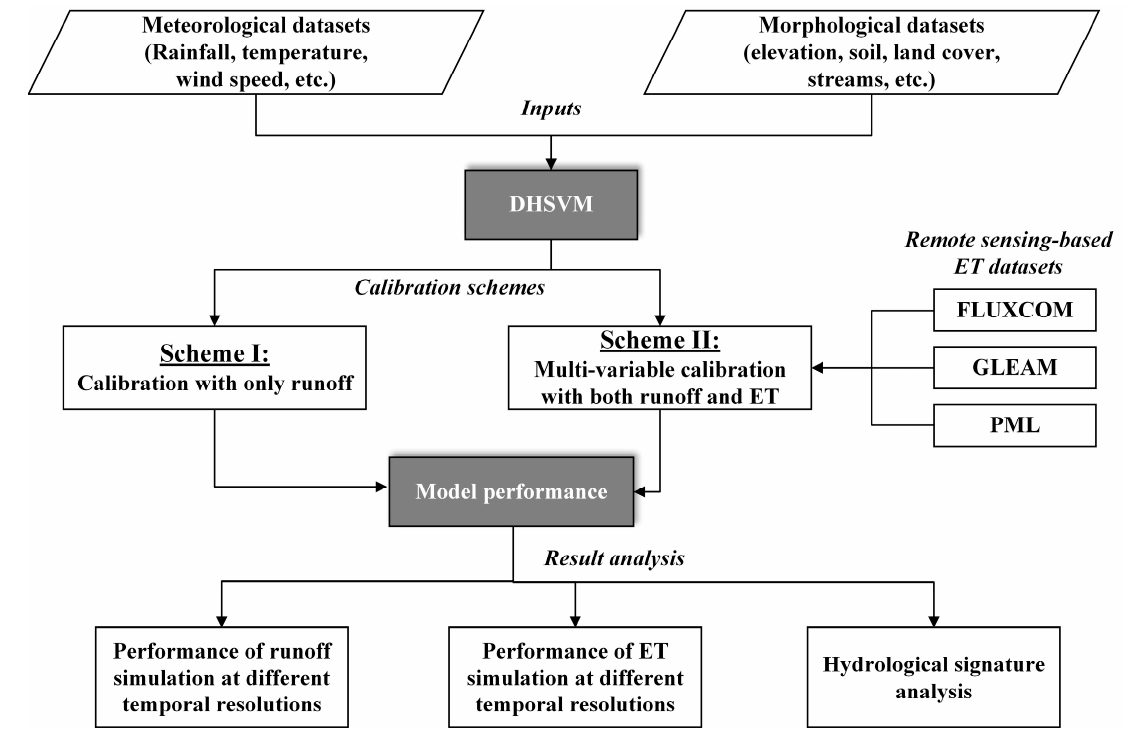
Figure 2. Flow chart of this